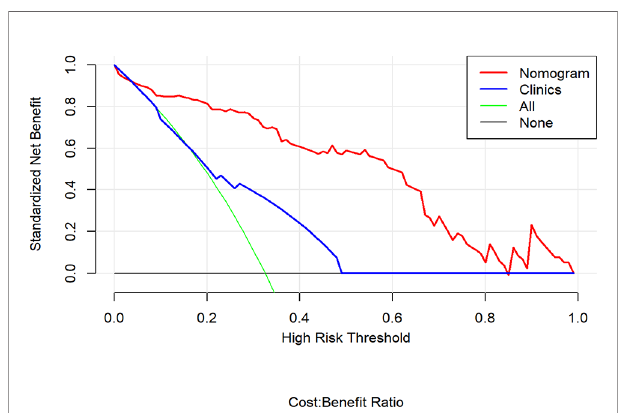
FIGURE 6 | Decision curve analysis for the nomogram compared with clinical model in the validation cohort. It can be concluded that when the threshold probability is over 10% approximately, the nomogram could provide extra pro fi t over the “ treat-all ” or “ treat-none ” scheme and the